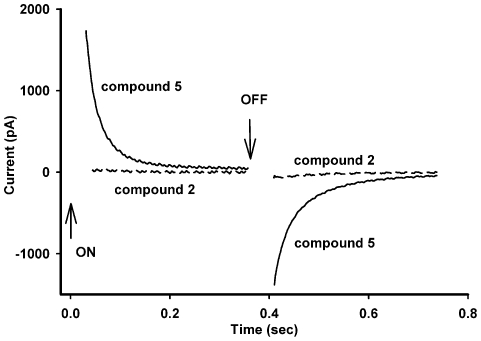
Differential permeability of a lipid membrane for compounds 2 and 5.Shown are time courses of electrical current after application of a voltage jump of V = 100 mV (at t = 0, ‘on’ response) in the presence of 10 nM of 5 or 2 and after switching off the voltage to zero (at t = 0.36 sec, ‘off’ response). Planar BLMs were formed from DPhPC (see MATERIALS AND METHODS). The experiments were performed in the buffer containing 10 mM Tris-HCl, pH 7.4 and 100 mM KCl. Shown is one representative experiment out of 3 with essentially the same results.